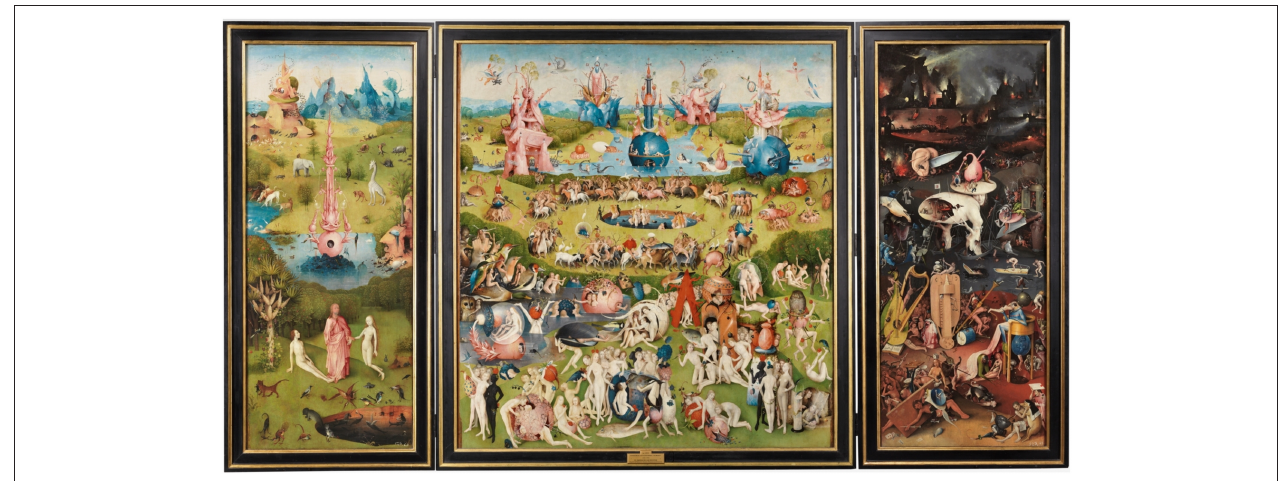
FIGURE 1 | Brain categorization as an artistic tool. Upper: Hieronymus Bosch, The Garden of Earthly Delights, oil on oak panels, Museo del Prado, Madrid.